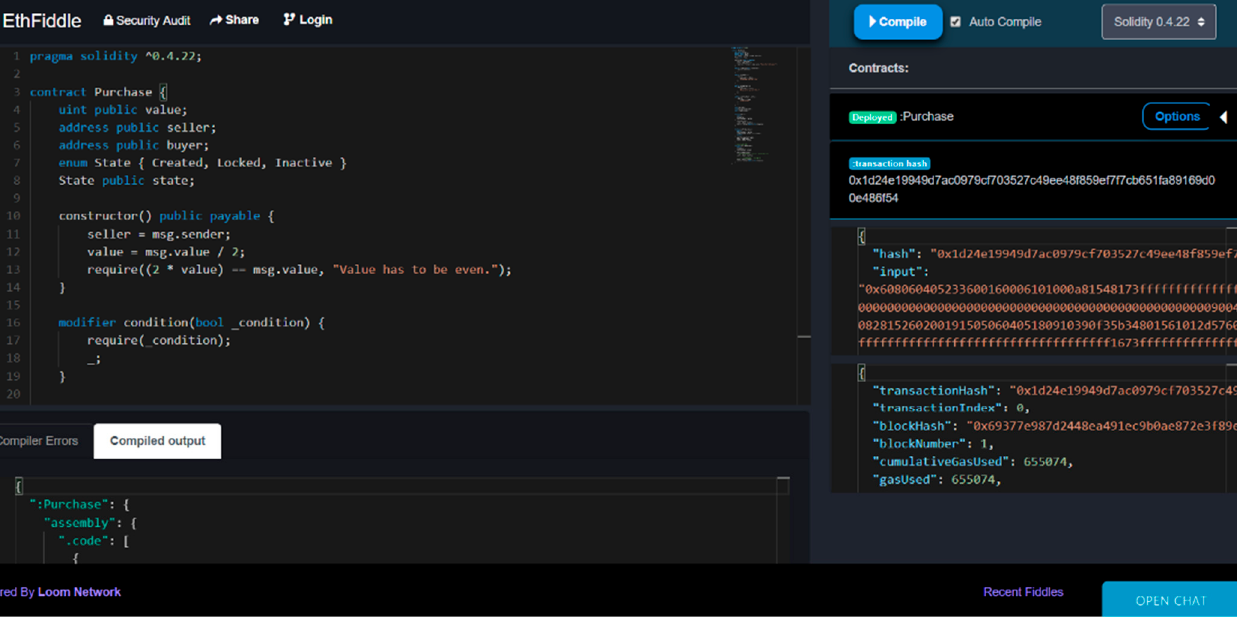
Figure 6. Trade smart contract compilation results.